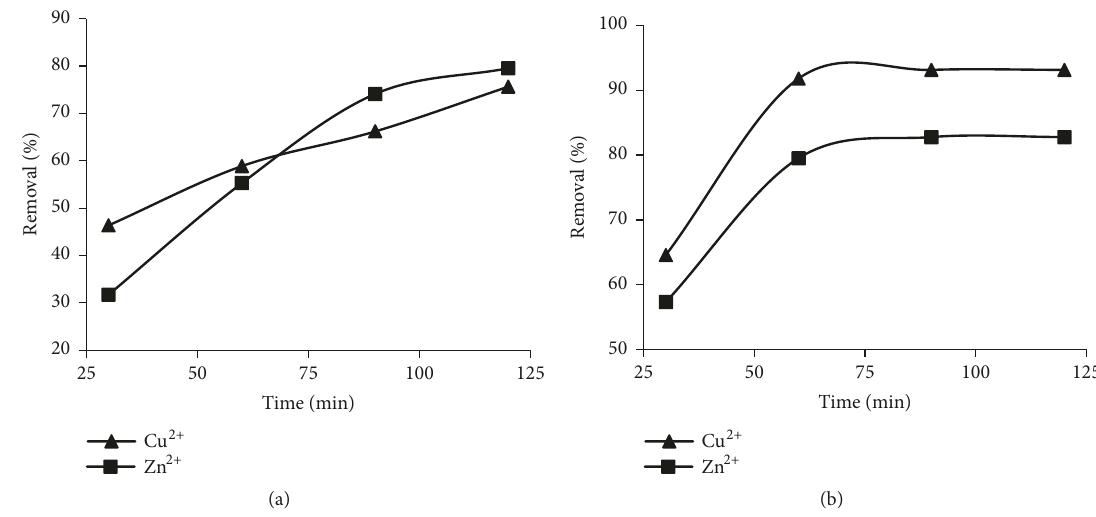
Figure 5: Effect of contact time on metal ion removal using (a) EC and (b) Fe 2 O 3 -EC.